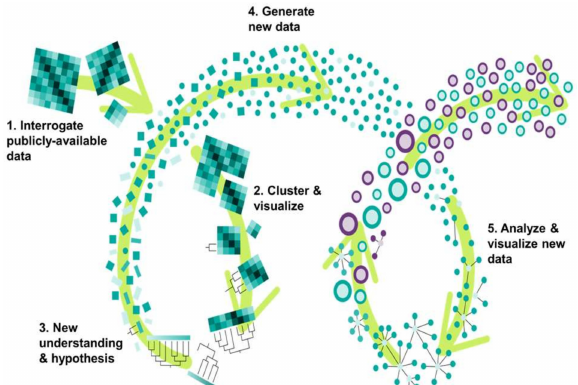
Figure 1. An integrated framework of iterative, systems-level analysis and experimental validation provides new